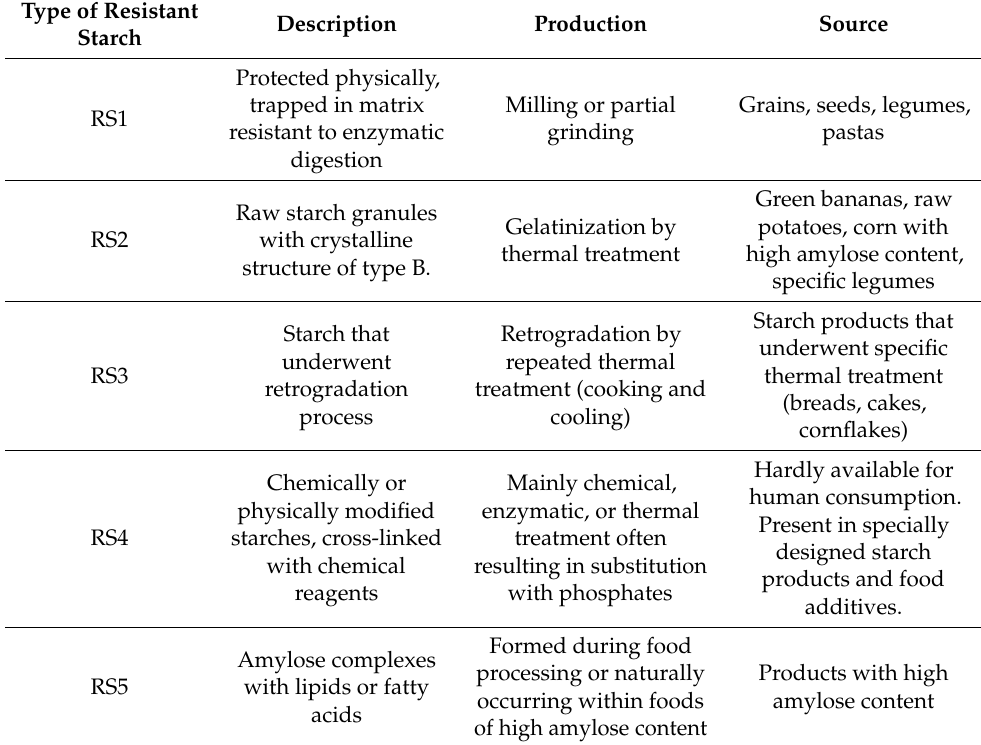
Grains, seeds, legumes, pastas Green bananas, raw potatoes, corn with high amylose content, specific legumes Starch products that underwent specific thermal treatment (breads, cakes, cornflakes) human